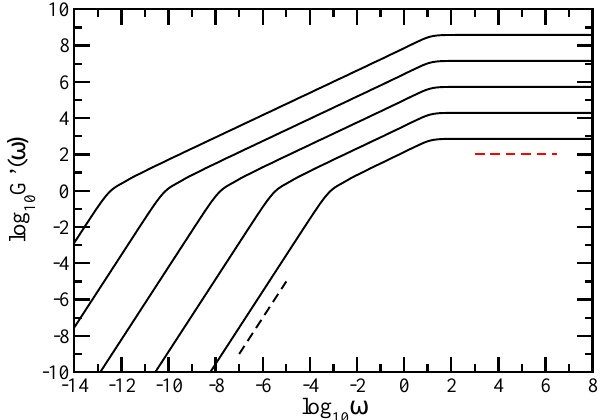
Figure 5. Storage modulus G (cid:48) ( ω ) , displayed in dimensionless units for the fractal cactus networks with N = 3 6 , 3 9 , 3 12 , 3 15 , and 3 18 from below. For guidance, the dashed black line indicates the slope 2 and the red dashed line indicates the slope 0, Rouse model.